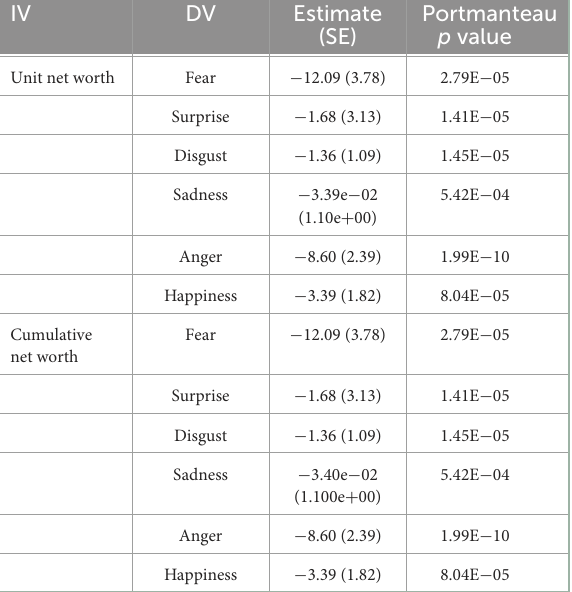
TABLE 7 Vector auto-regressive model ( p = 1) between emotions and fund performance of the E Fund Blue Chip Select Mix Fund. IV DV Estimate